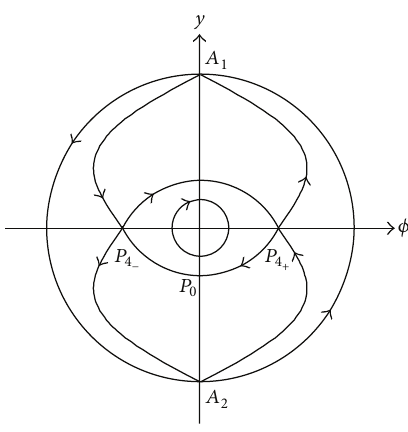
Figure 11: ( 𝛽 > 0 , 𝑎 < 0 , 𝑏 = 0 , 𝑐 < 0